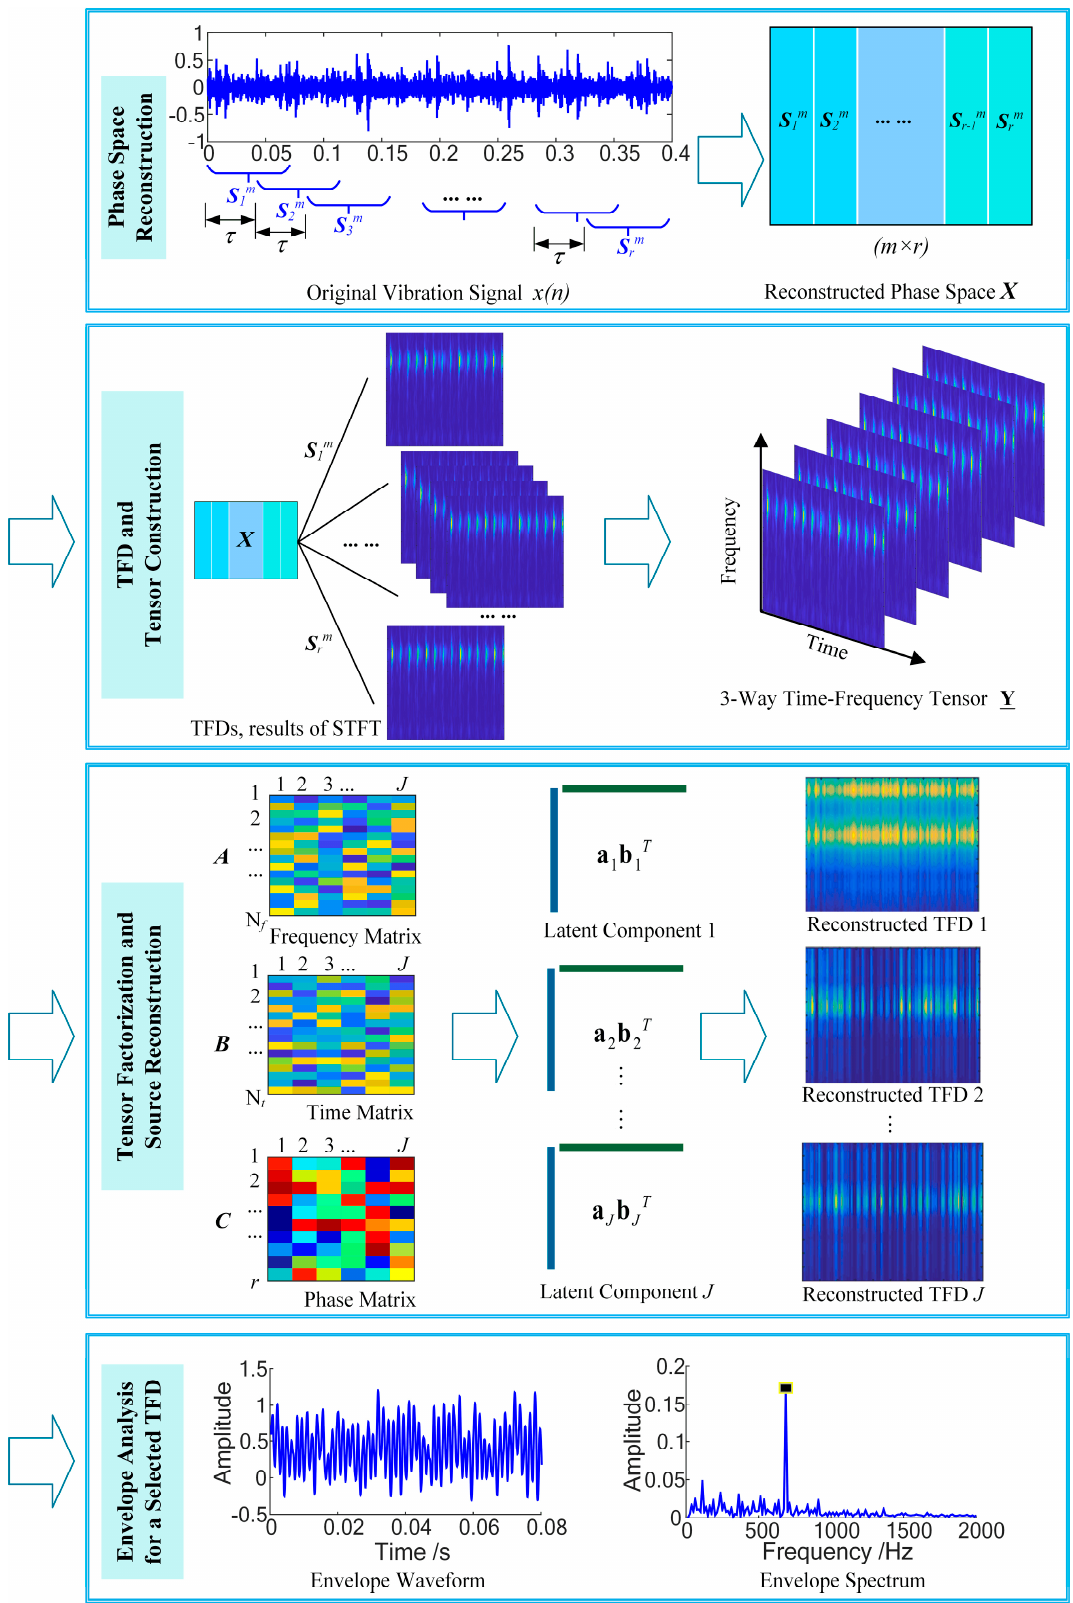
Figure 3. The overall procedure of the sparse non-negative tensor factorization (SNTF)-based feature extraction for machinery faults.